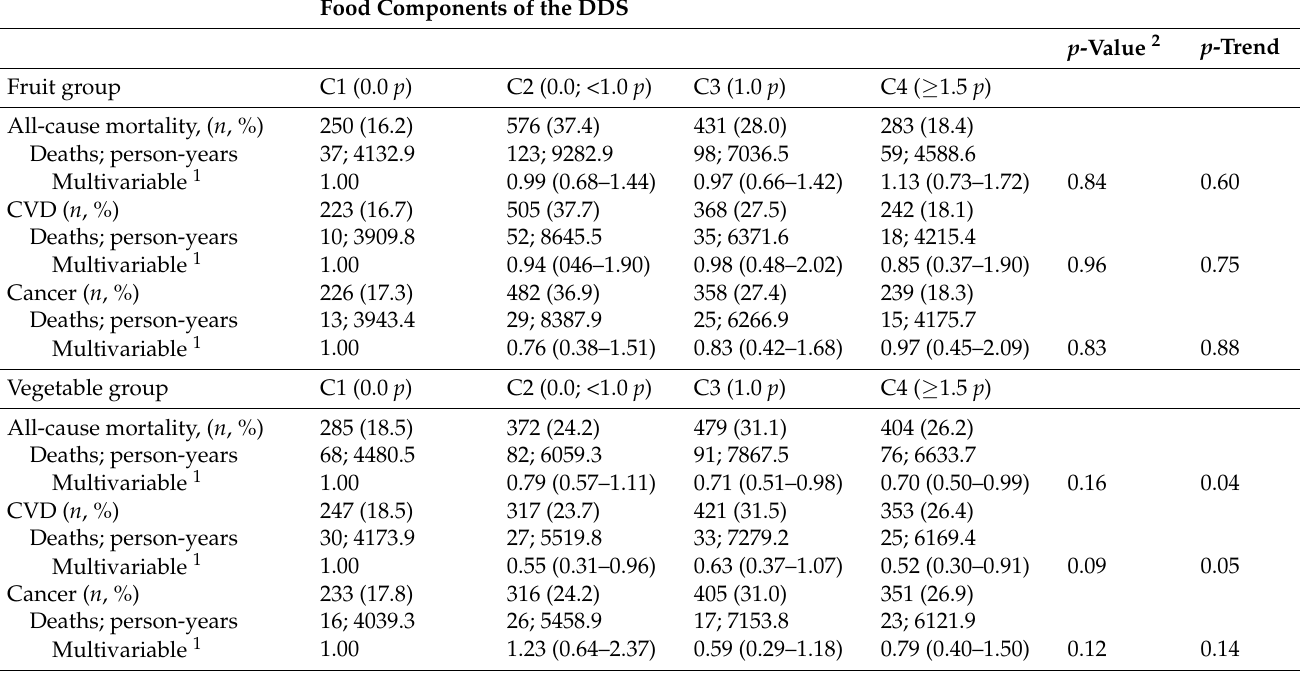
Table 4. Associations between food groups of the dietary diversity score and all-cause, cardiovascular disease and cancer mortality among participants of the Valencia Nutrition Study in Spain ( n = 1540).